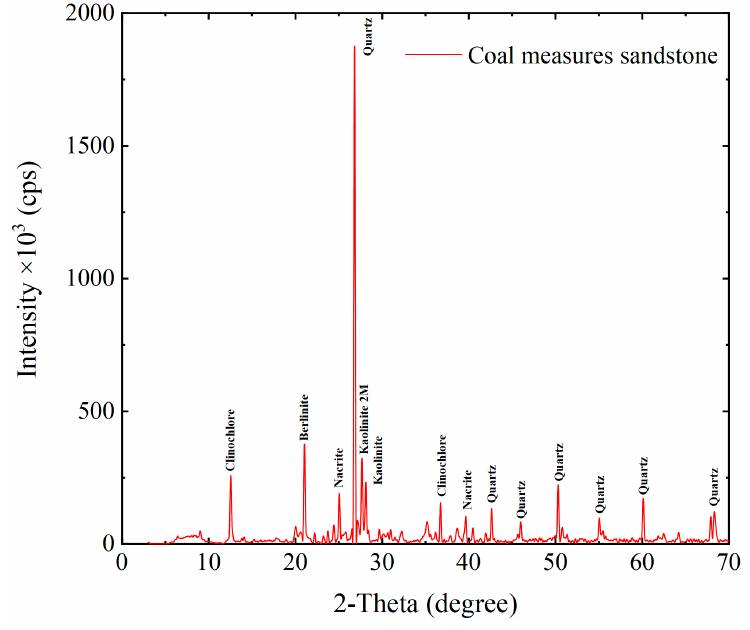
Figure 4. X-ray diffraction (XRD) study of sandstone.